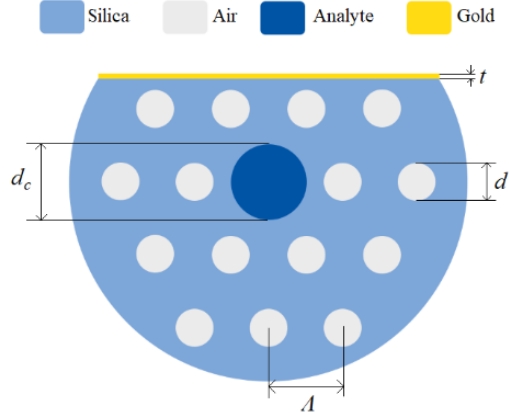
Figure 14. Cross section of the D-shaped PCF-based plasmonic biosensor in [37] with air holes diameter d , analyte-core diameter d c , holes pitch Λ , and gold layer thickness t . Reproduced with permission from Reference [37], Copyright 2019, IEEE.